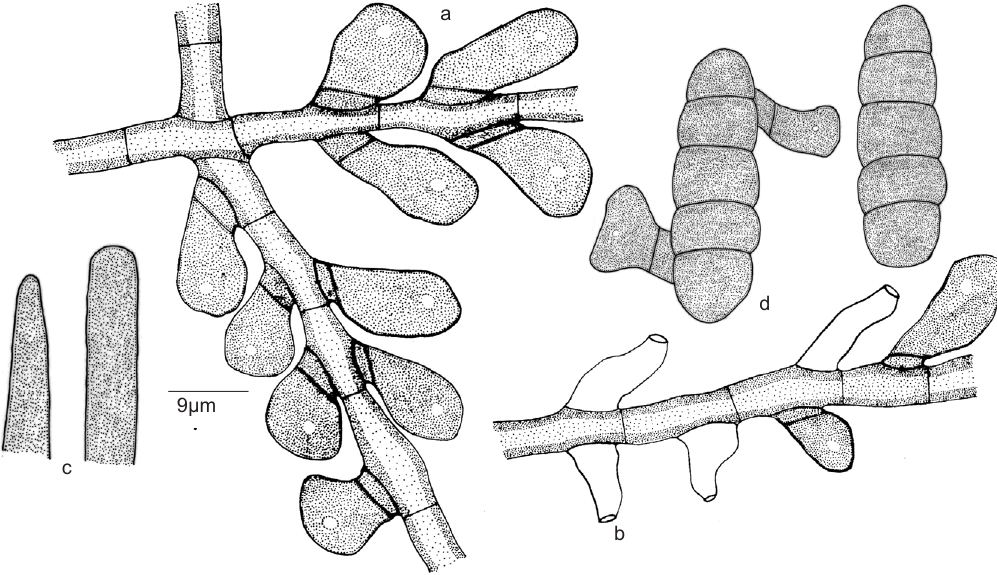
Figure 4. Meliola lophopetaligena sp. nov. a - Appressorium; b - Phialide; c - Apical portion of the mycelial setae; d -